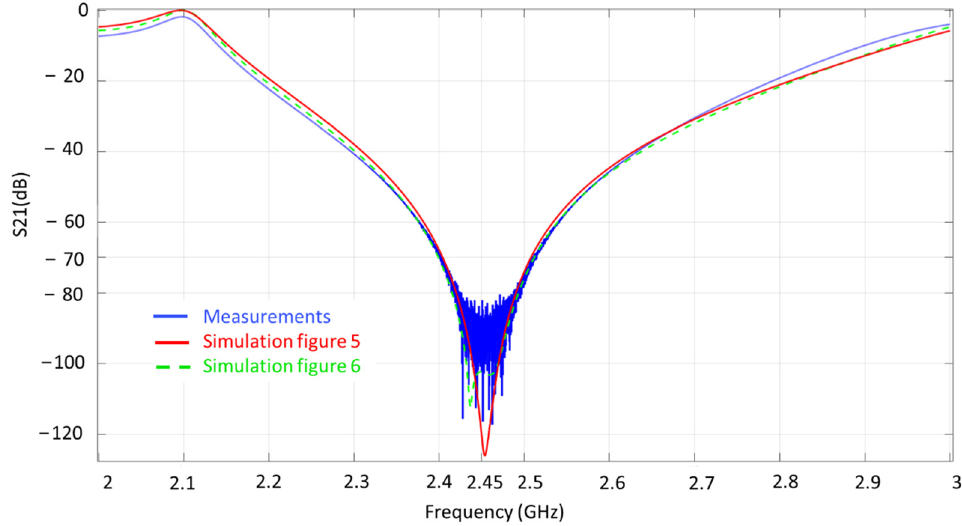
Figure 11. Three-stage coaxial-cavity filter validation: measurements (blue), simulations without transitions (red), and simulations with DIN 7/16 connectors (green).